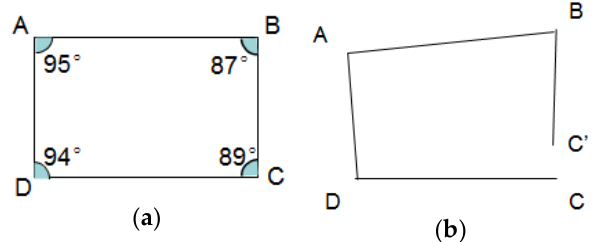
Figure 18. A kind of topology error caused by inaccurate angles: ( a ) a rectangle and four calculated inner angles; ( b ) the topology result of the rectangle using inaccurate inner angles. C’ and C don’t overlap.